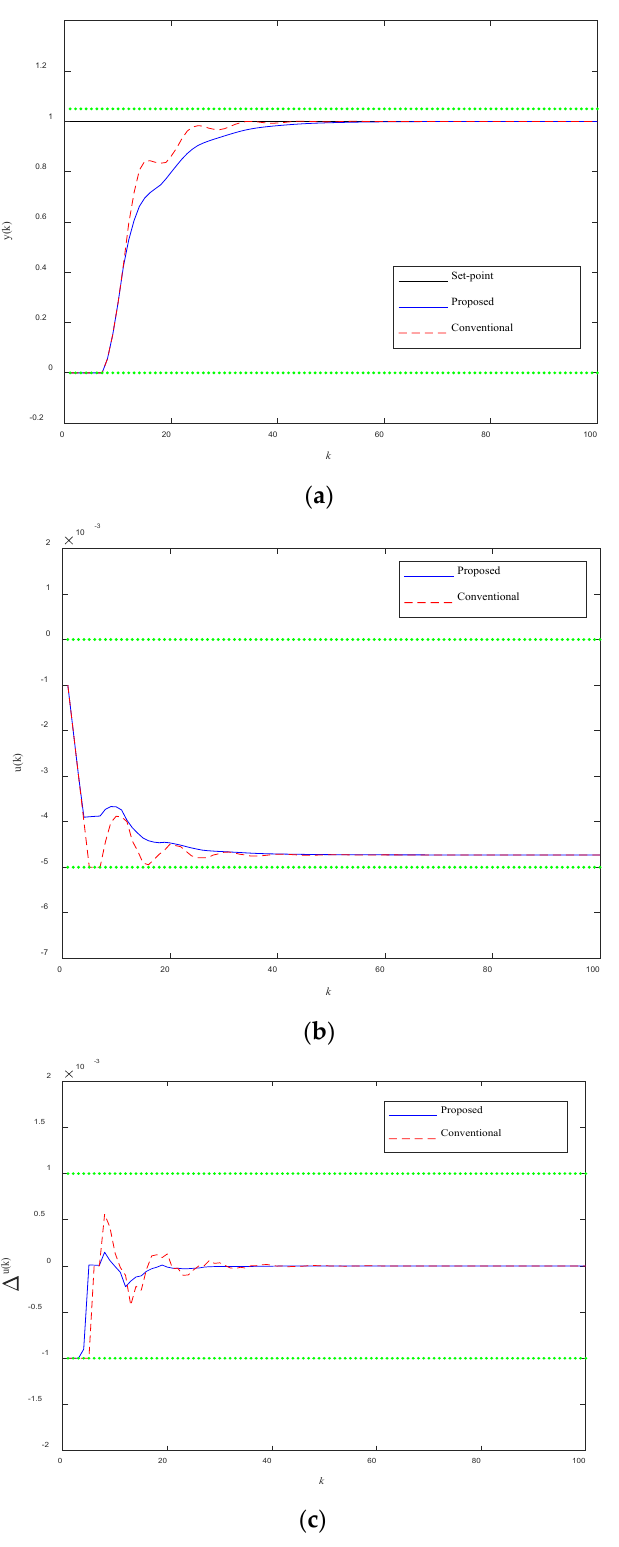
Figure 5. ( a ) Output responses under case 2 and loose constraints; ( b ) input responses under case 2 and loose constraints; ( c ) input increment responses under case 2 and loose constraints.